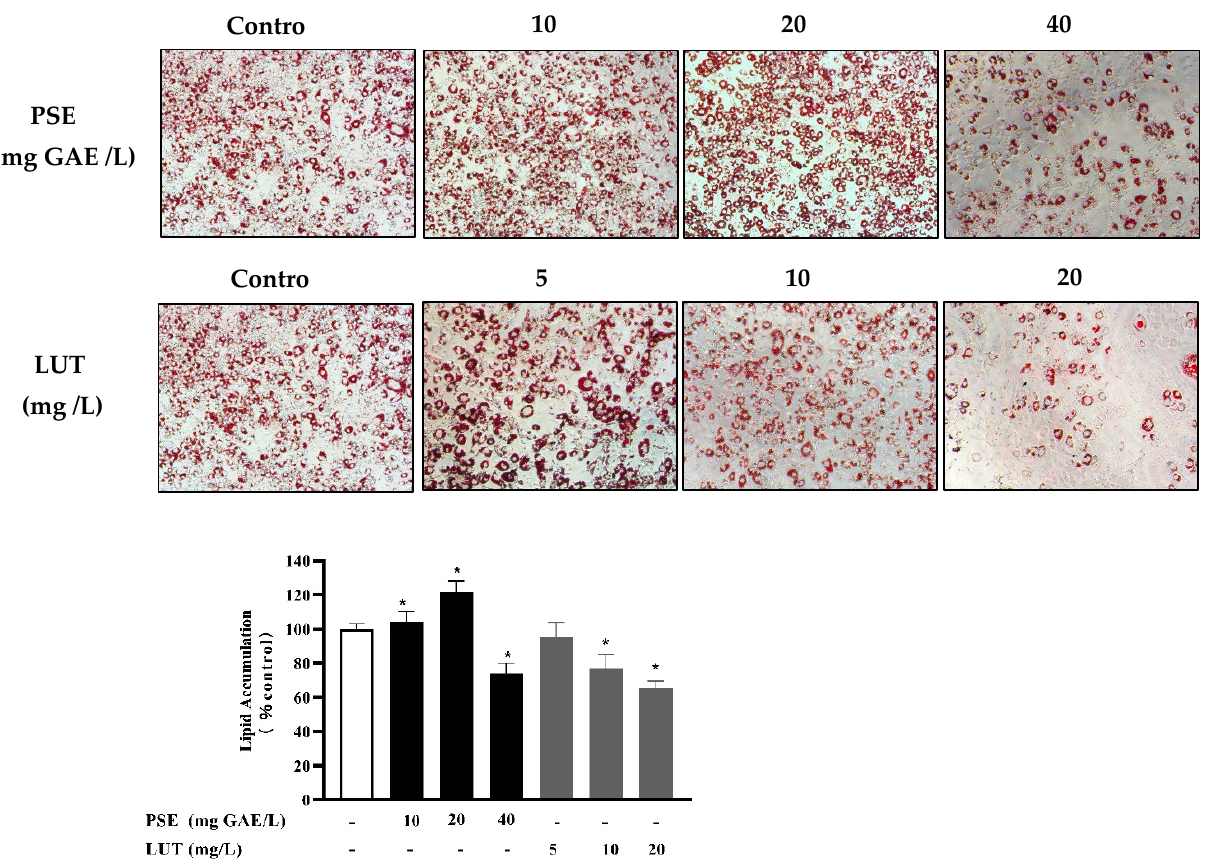
Figure 2. The effect of PSE and LUT on the lipid accumulation in 3T3-L1 adipocytes after 10 d. ( A ) Oil Red O staining of the 3T3-L1 cells treated with different PSE concentrations (0 mg GAE/L, 10 mg GAE/L, 20 mg GAE/L and 40 mg GAE/L) at 200 × magnification. ( B ) Oil Red O staining of the 3T3-L1 cells treated with different LUT concentrations (0 mg/L, 5 mg/L, 10 mg/L and 20 mg/L) at 200× magnification. Scale bar = 200 μ m. ( C ) Quantification by measuring the absorbance at 510 nm. Data are presented as the mean ± S.D. from three independent experiments. * Significant differences are indicated by p < 0.05.